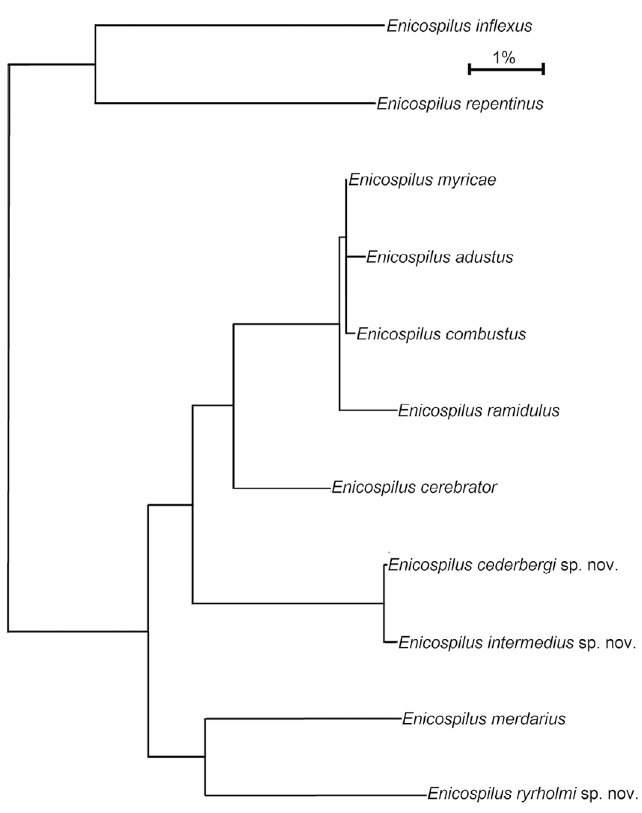
Fig. 10. Relationships among Swedish species of the genus Enicospilus according to their DNA- barcodes. The neighbour-joining phylogenetic tree was constructed on the basis of Kimura 2-parameter distances. All samples are from Sweden. The scale line indicates 1% sequence